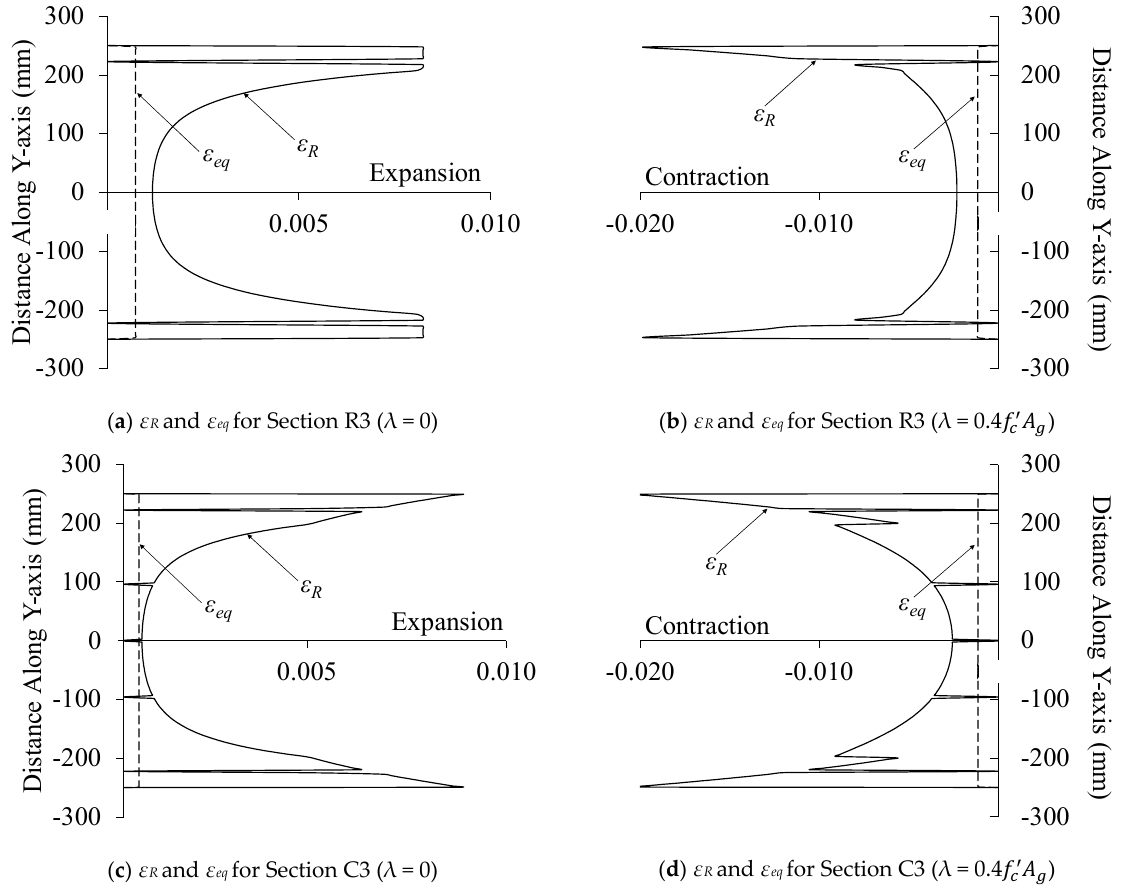
Figure 11. Residual and equivalent strain distribution along column R3 and C3 cross-sections.